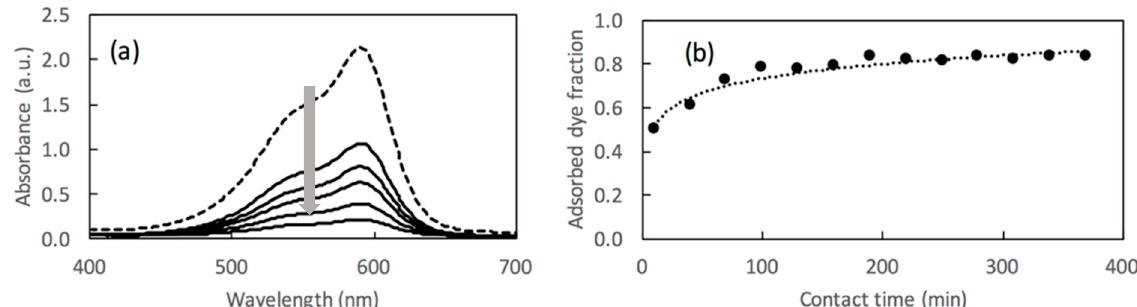
Figure 3. UV-vis spectra of CV solution before (broken-line curve) and after (solid-line curves) a prolonged contact with BBS-functionalized magnetic material for 6 h ( a ), and relative adsorbed dye fraction trend as determined by reading 592 nm absorbance ( b ). The grey arrow in section ( a ) indicates the trend of the absorption in time.